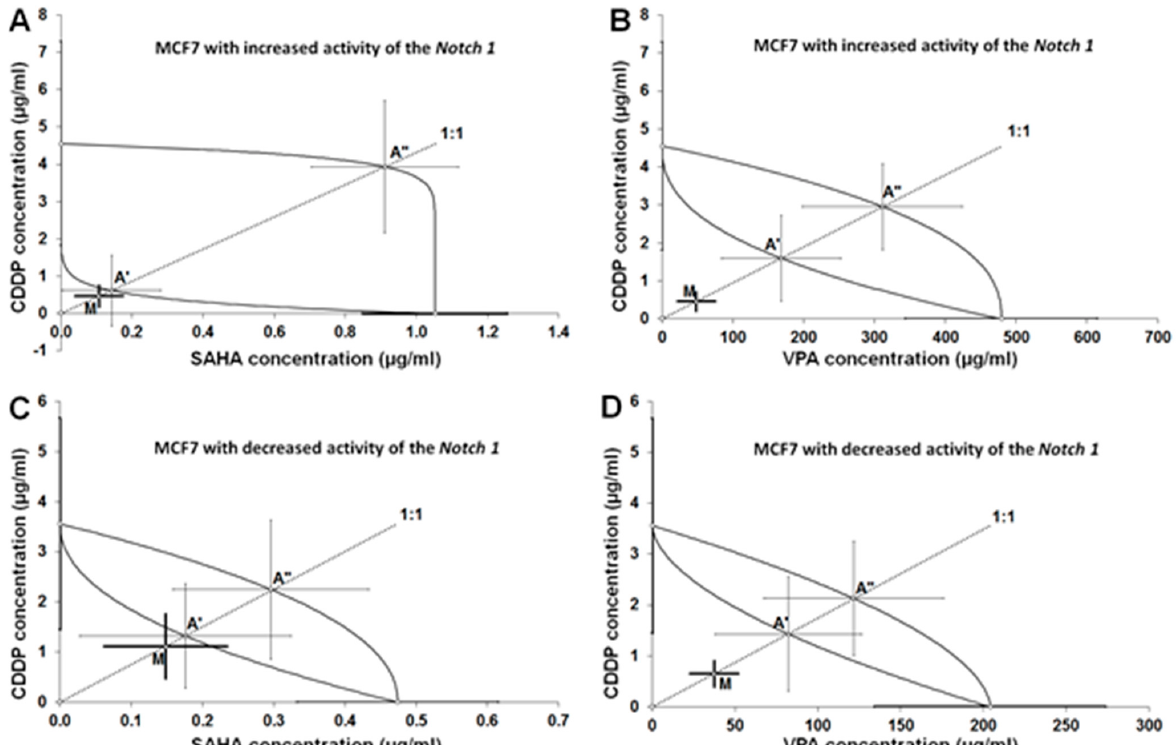
Figure 3. Isobolograms illustrating additive interactions between CDDP, SAHA, and VPA with respect to their anti- proliferative effects on MCF7 cells with increased ( A , B ) and decreased ( C , D ) Notch1 activity. Median inhibitory concentra- tions (IC 50 ± S.E.M.) for CDDP, SAHA, and VPA are plotted graphically on the X-and Y-axes, respectively. The lower and upper isoboles of additivity represent the curves connecting the IC 50 values for CDDP and SAHA or VPA administered alone. The dotted line corresponds to the fixed ratio of 1:1 for the combination of CDDP with SAHA or VPA. The points A’ and A” depict the theoretically calculated IC 50 add values (± S.E.M.) for both lower and upper isoboles of additivity. The point M represents the experimentally derived IC 50 mix value (± S.E.M.) for total dose of the mixture that produced a 50% anti-proliferative effect in MCF7 cells. The experimentally derived IC 50 mix value is placed close to the point A’ for the lower isobole of additivity ( A , C ), indicating additive interaction between CDDP and SAHA or VPA. Although the exper- imentally derived IC 50 mix value is placed below the additive point A’ ( B , D ), no statistical significance was attained between CDDP and SAHA or VPA, indicating additive interaction with a tendency toward synergy in MCF7 cells. Table 3. Isobolographic analysis of interactions between CDDP and SAHA or VPA at the fixed- ratio combination of 1:1 on cells with increased or decreased activity of Notch1 with reference to native MCF7 cells [22].